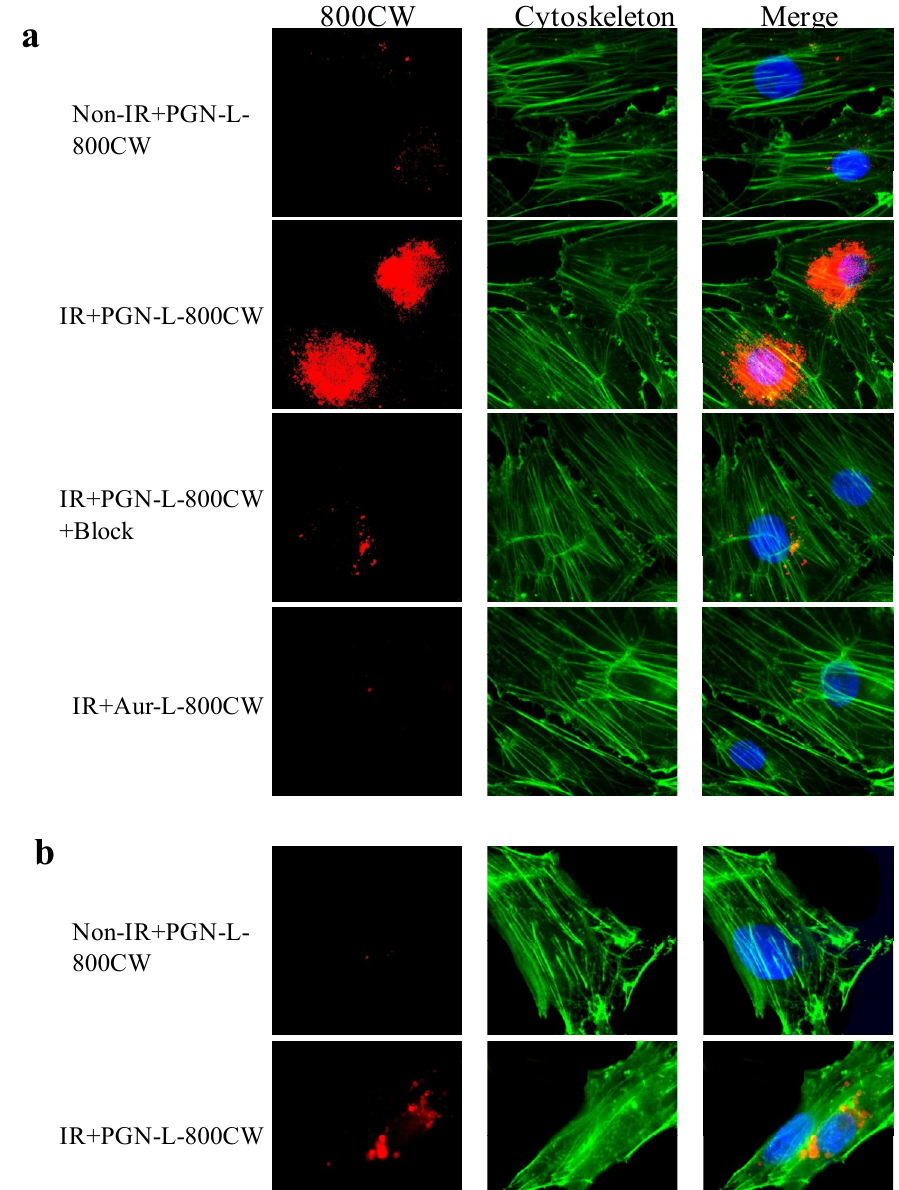
Figure 2. In vitro specificity studies of PGN-L-800CW. ( a ) Immunocytochemistry of ABAE endothelial cells pretreated with/without radiation (IR) of a single dose of 6 Gy. Twenty-four hours later, the cells were incubated with either PGN-L-800CW or the control Aur-L-800CW for 1 h before fixation and subsequent staining. Merged fluorescence images showed minimal 800CW (red) signals from non-irradiated cells or Aur-L-800CW treated irradiated cells. By contrast, massive 800CW signals were seen intracellular in the PGN-L-800CW treated irradiated cells. Prior treatment with the full length PGN635 blocked majority of 800CW signals; ( b ) Similar results were observed for the U87 glioma cells that IR induced PS exposure and internalized 800CW signals while minimal 800CW was detected in the non-IR treated cells. Note: green, cytoskeleton actin stained by phalloidin; blue: DAPI stained